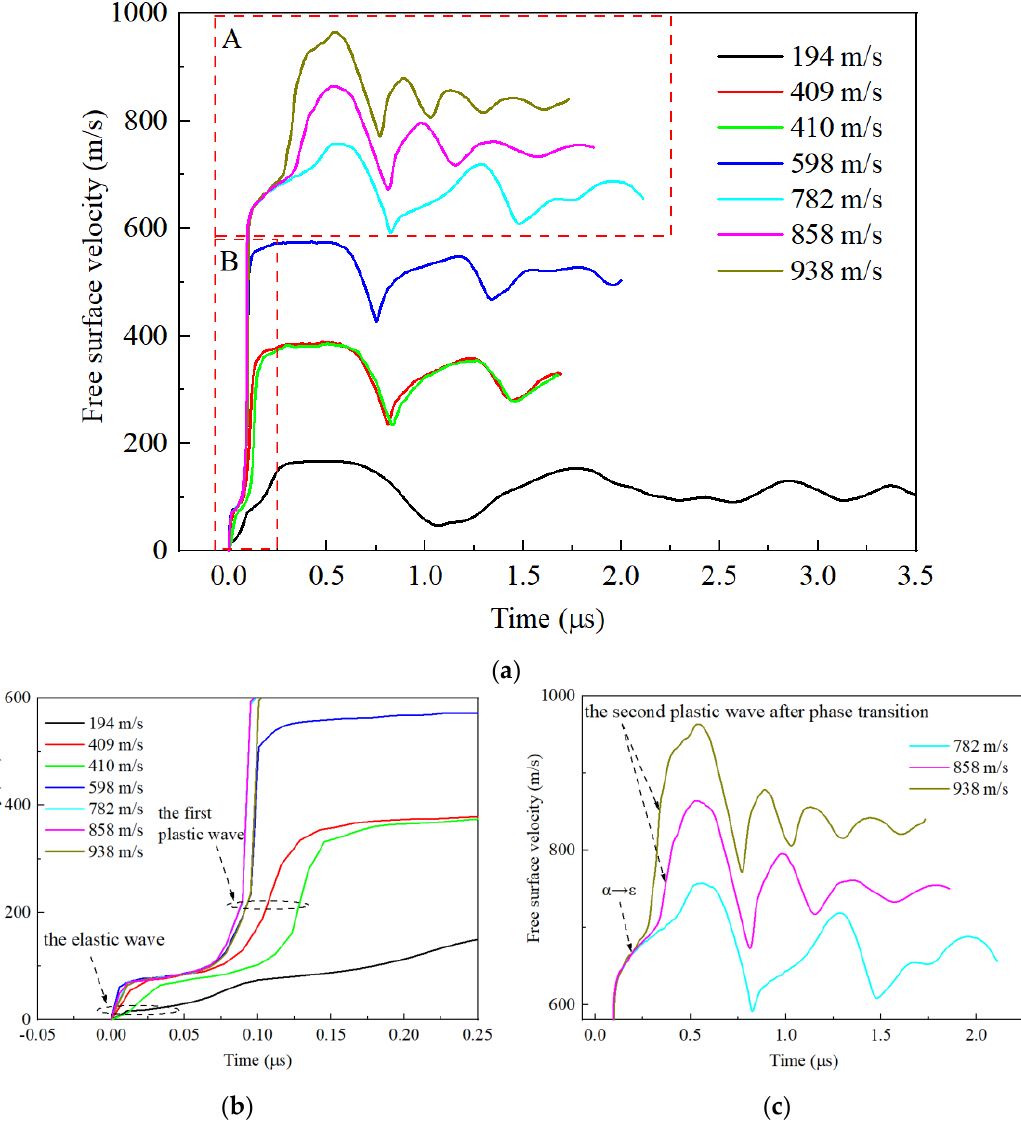
Figure 4. Rear free surface velocity vs. time for all specimens at flyer impact velocities from 194 to 938 m/s. ( a ) measured curves; ( b ) zone A; ( c ) zone B.